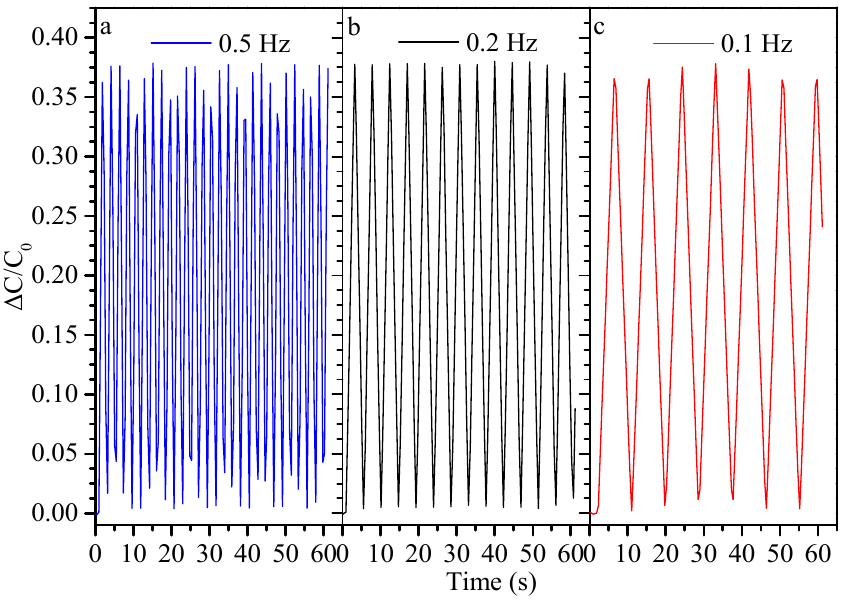
Figure 6. Relative capacitance changes at 50% elongation, for different strain cycle frequencies, after 10,000 strain cycles.